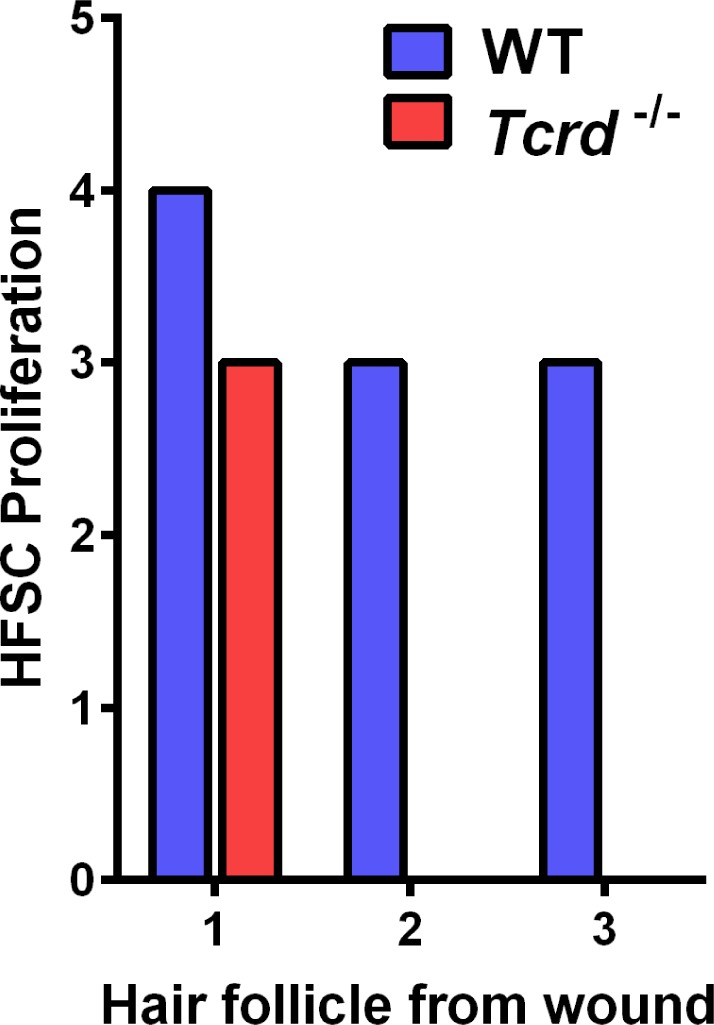
Effect of γδT-cells on HFSC proliferation.Quantification of EdU+ hair follicle stem cell (HFSC) proliferation in the first three hair follicles adjacent to wounds in mice from the labeled genotypes.